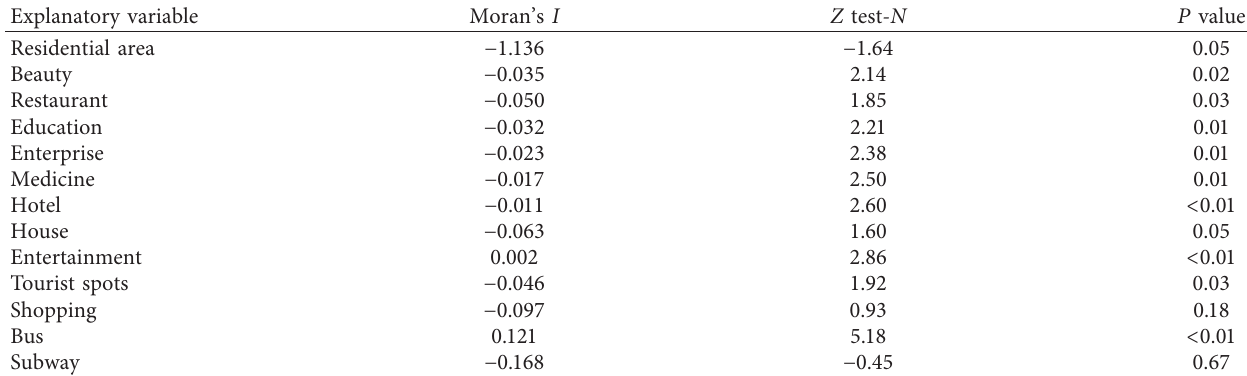
Table 3: Moran’s I test of explanatory